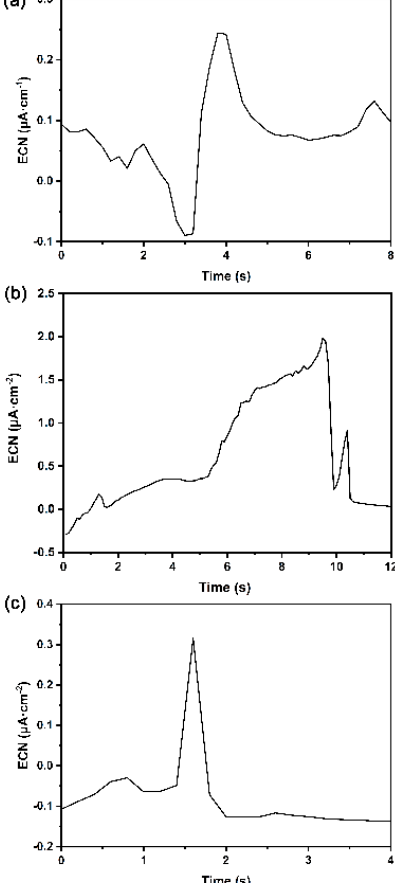
Figure 12. Different types of current transients observed on DSS2205 specimens in 1 M NaCl solution: